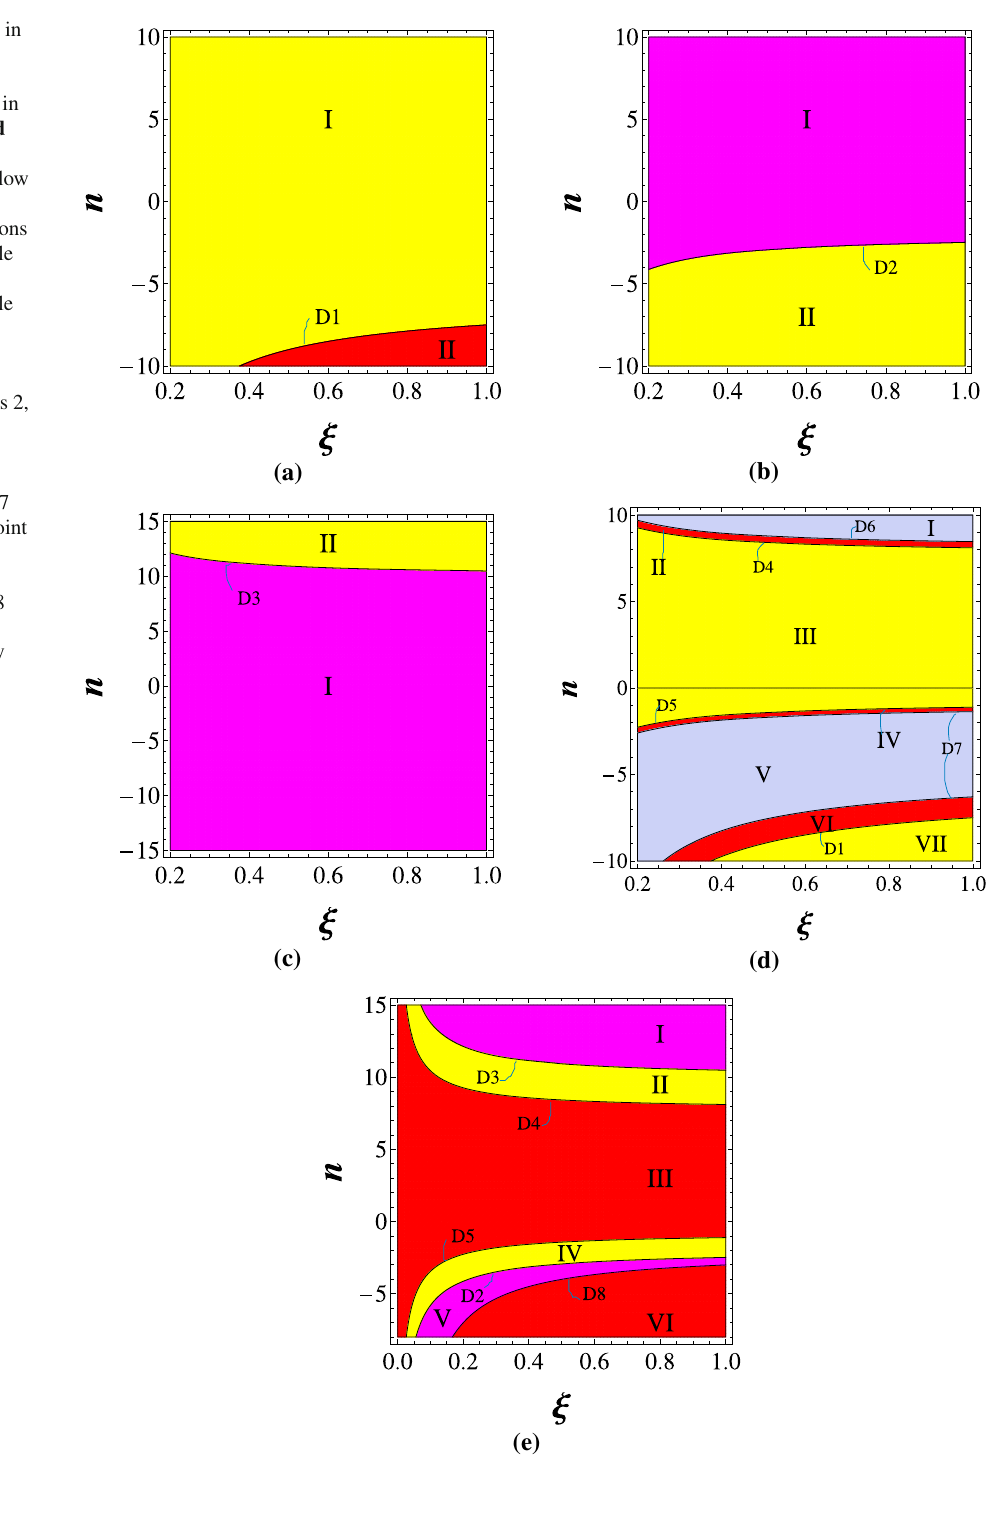
Fig. 2 Bifurcation diagrams in (ξ, n ) parameter space exhibiting different local stability regions of points B 1 in a , B 2 + in b , B 2 − in c , B 3 in d and B 4 in e for the case of w = 0. In each panel, the yellow color regions correspond to saddle regions, red color regions correspond to regions of stable node, blue color regions correspond to regions of stable focus, magenta color regions correspond to regions of unstable node. Black colored curves D1–D5 (see statements 2, 3, 4 for their expressions) separating different regions represent the non-hyperbolic curves. The curves D6 and D7 represent the curves where point B 3 changes between a stable node and stable focus nature. Line n = 0 in d and curve D8 represents non-existence of points B 3 and B 4